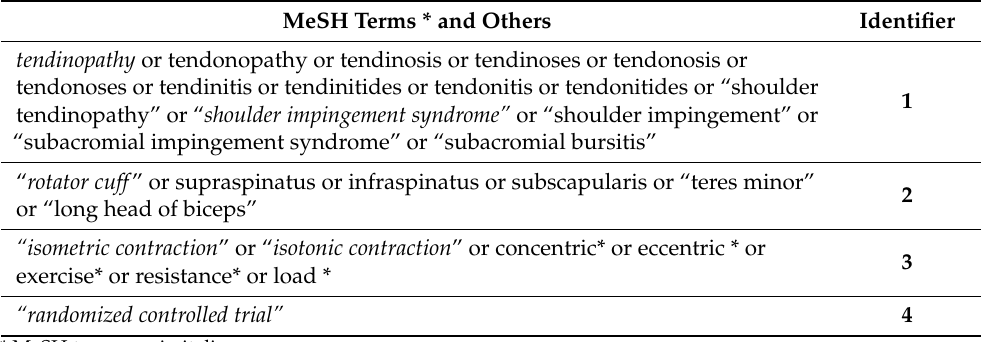
Table A1. Search strategy terms ordered by meaning.